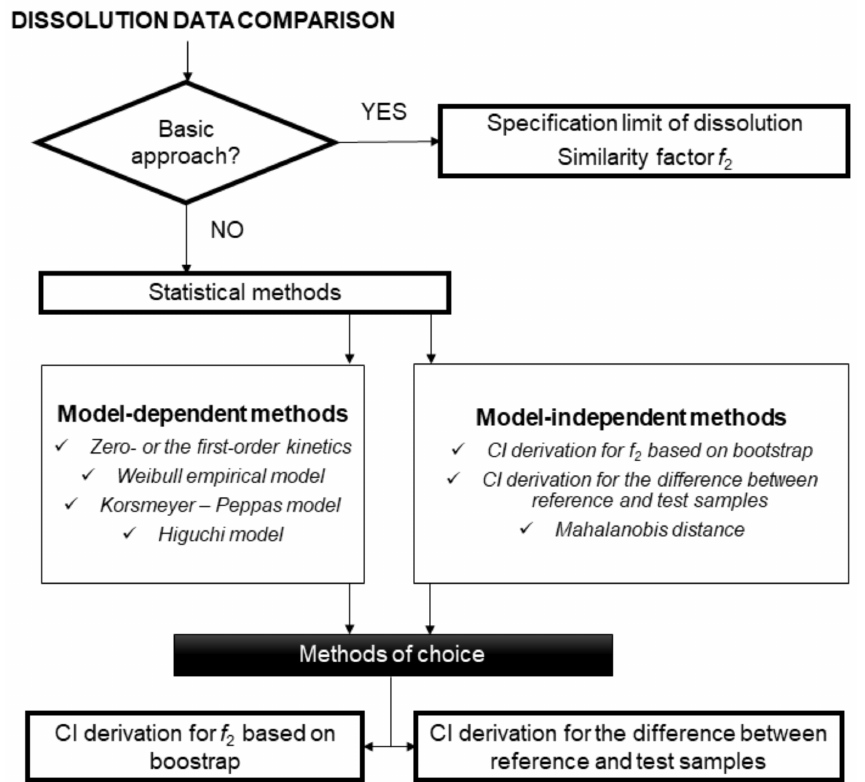
Figure 1. Schema of the current strategy in a dissolution data comparison by the EMA and FDA